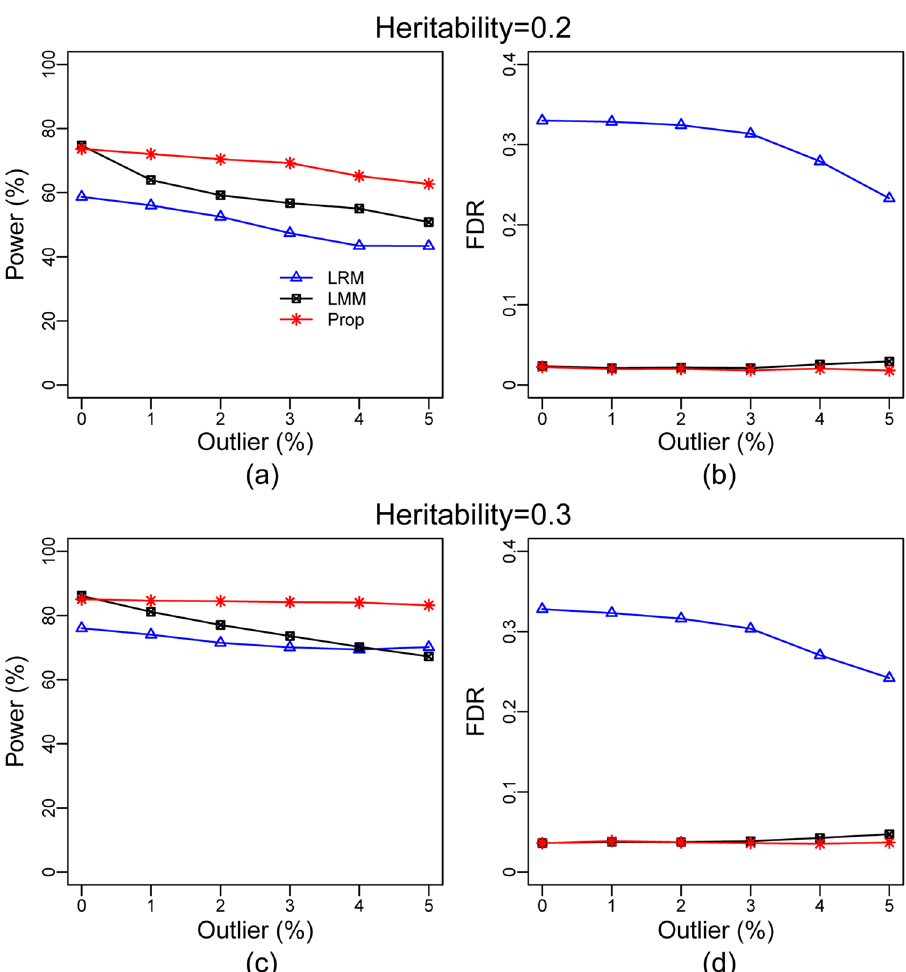
Figure 3. Results computed by LRM, LMM and the proposed methods based on partial simulation with the real dataset ( a ) plot of statistical power against the rate of phenotypic outliers at heritability h 2 = 0.2 and at the cutoff p -value 10 –5 . ( b ) Plot of FDR against the rate of phenotypic outliers at h 2 = 0.2 and at cutoff = 10 –5 . ( c ) plot of statistical power against the rate of phenotypic outliers at h 2 = 0.3 and cutoff 10 –5 ( d ) plot of FDR against the rate of phenotypic outliers at h 2 = 0.3 and cutoff 10 –5